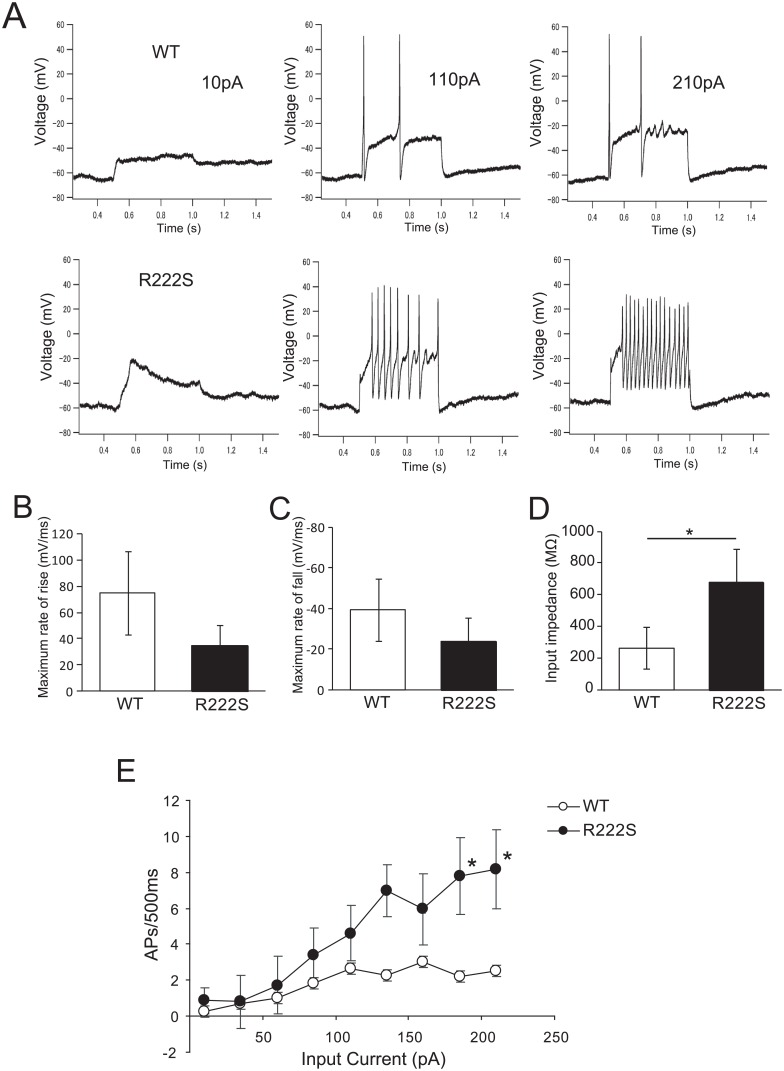
R222S mutation increases excitability in DRG neurons.(A) Small DRG neuron (< 25μm) responses to 500-ms depolarizing current steps of 10, 110, and 210 pA in WT and R222S mice. The parameter of the first AP obtained during current injections of 210 pA, showing calculated maximum rate of rise (B) and fall (C) of AP firing. Open and closed circles represent WT (n = 4) and R222S mice (n = 5), respectively. (D) Input impedance was measured at an injection current of 10 pA. Open and closed columns represent WT (n = 6) and R222S mice (n = 5), respectively. (E) Comparison of repetitive action potentials between WT and R222S mice. Open and closed circles represent WT (n = 6) and R222S mice (n = 5), respectively. The range of 500-ms-step current injections was 10–210 pA. Data are presented as mean ± S.E.M. (*p < 0.05; two-sided Student’s t test).